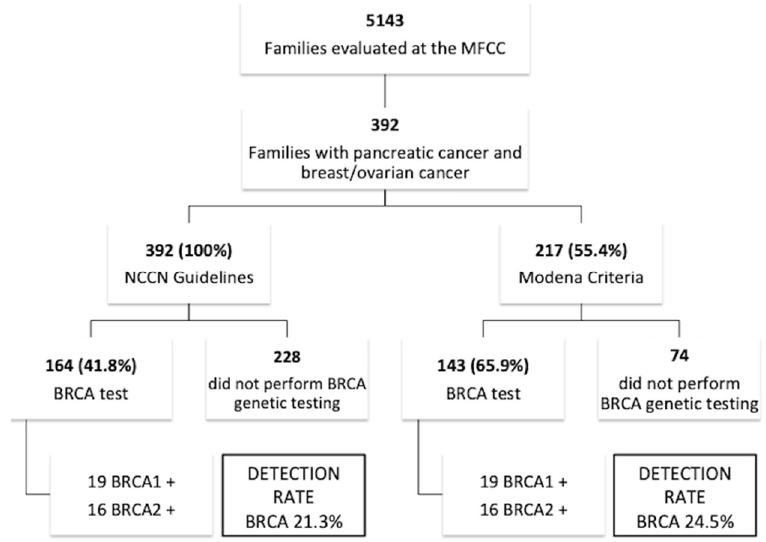
Figure 1. Study flow chart.